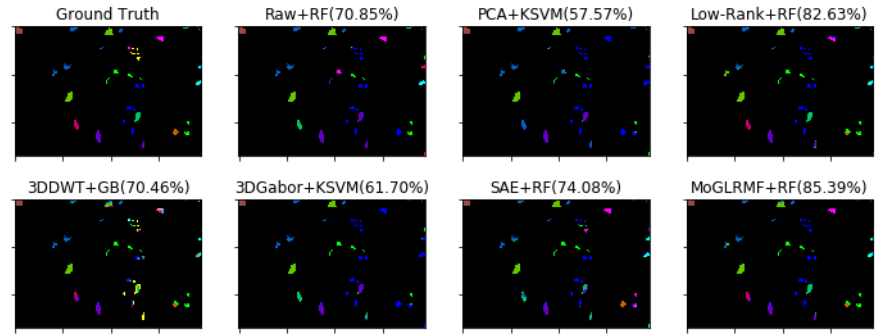
Figure 5. Classification maps of different methods on Kennedy Space Center (KSC) dataset (1% proportion training samples for each